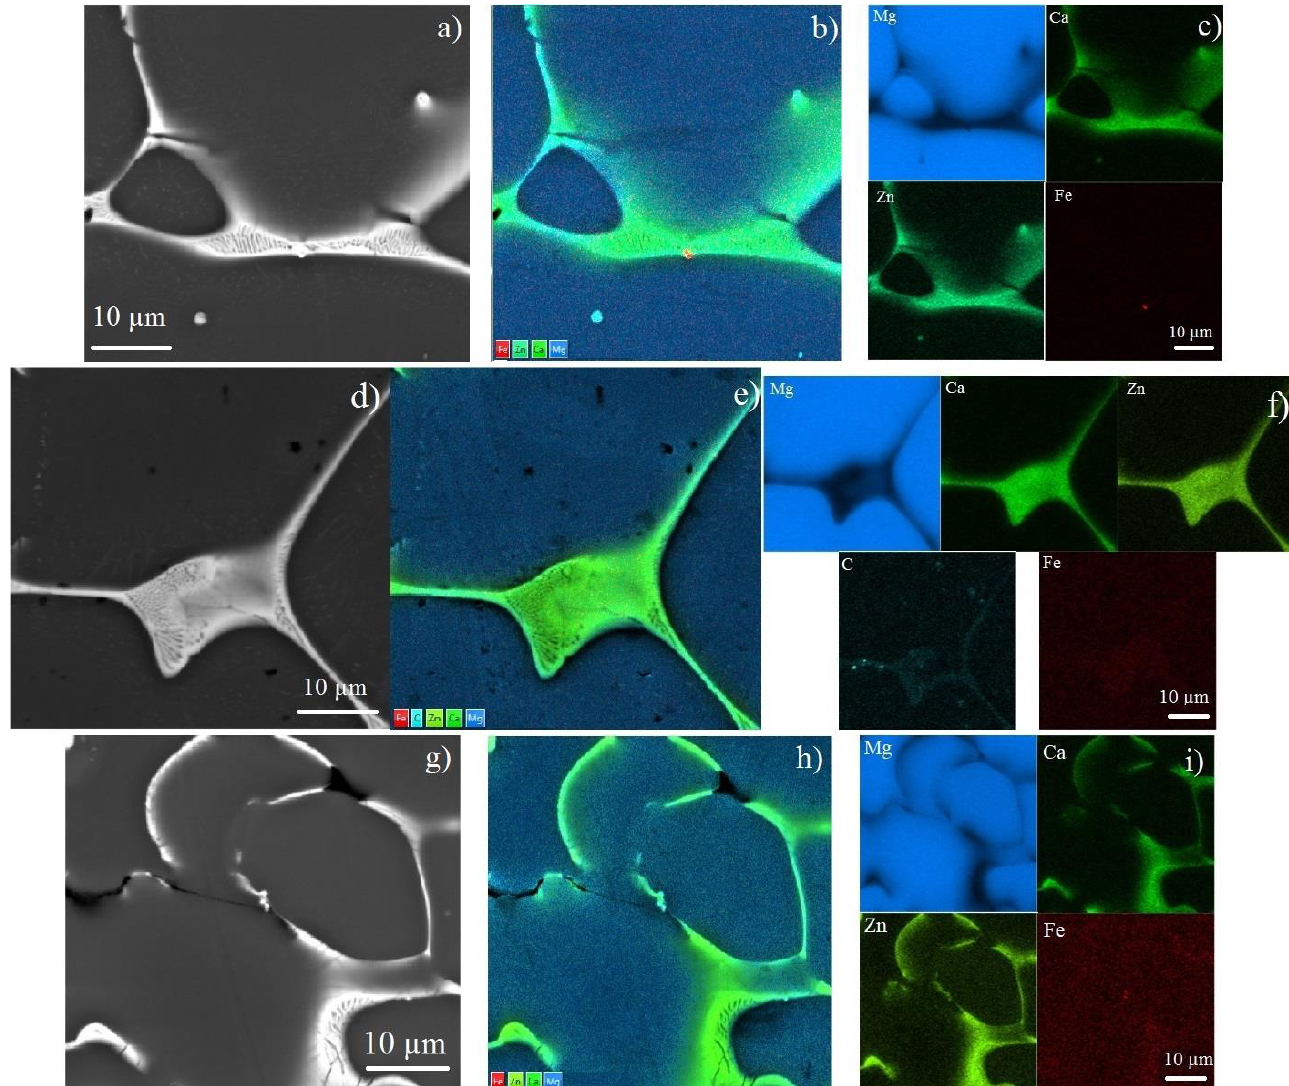
Figure 4. SEM images ( a,d,g ) and results of mapping by elements ( b,c,e,f,h,i ) of magnesium alloys Mg – Ca – Zn reference ( a – c ), Mg – Ca – Zn – ND ( d – f ) and Mg – Ca – Zn US ( g – i ).